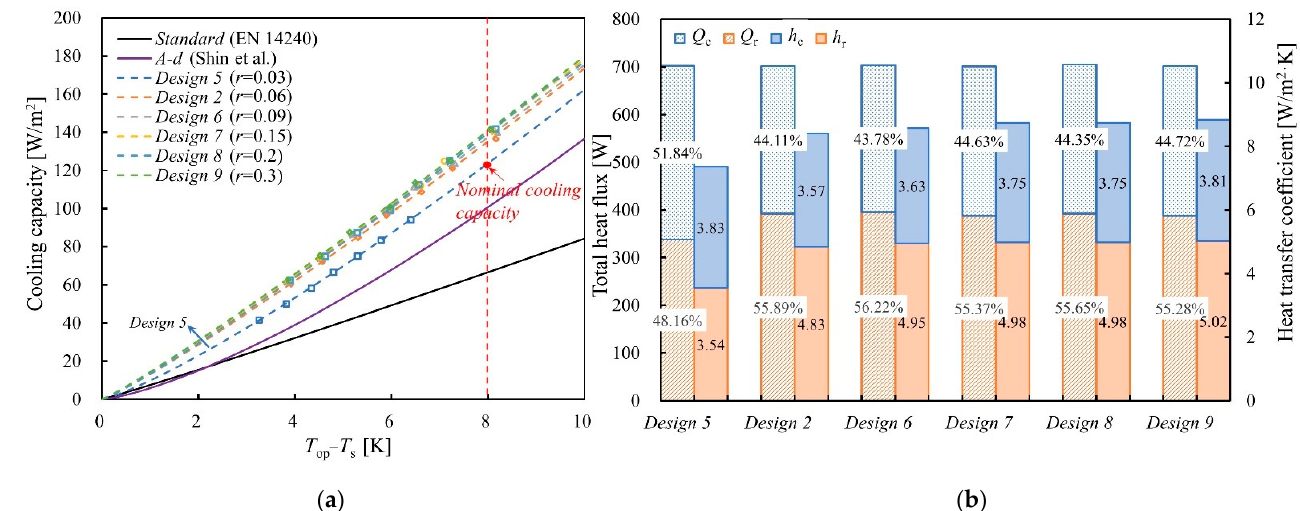
Figure 8. Comparison of different curvature radii ( a ), cooling capacity curves [27,32] ( b ), and thermal performances under a cooling load of 1405.02 W.